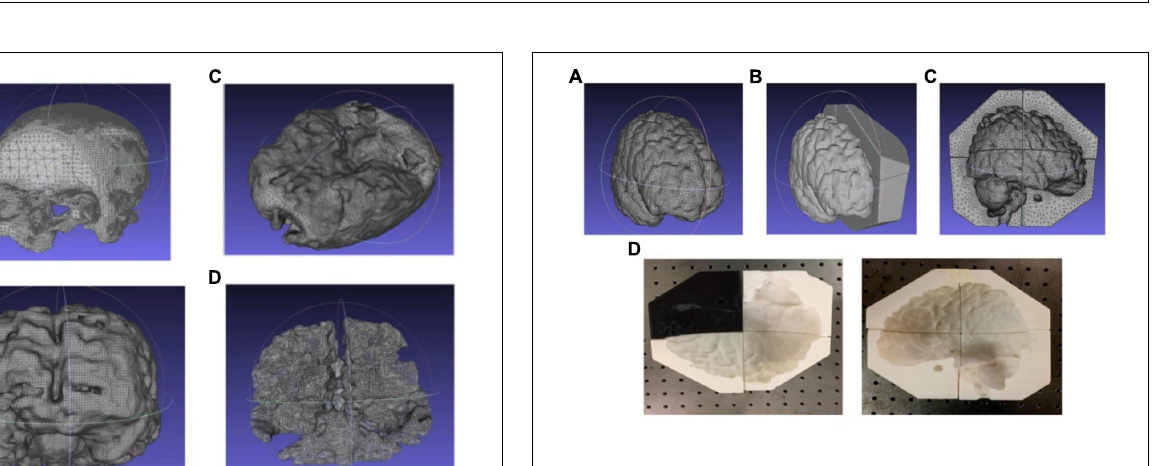
FIGURE 4 | The histogram of the MRI image stack and different window functions applied to separate gray matter, white matter, and skull.